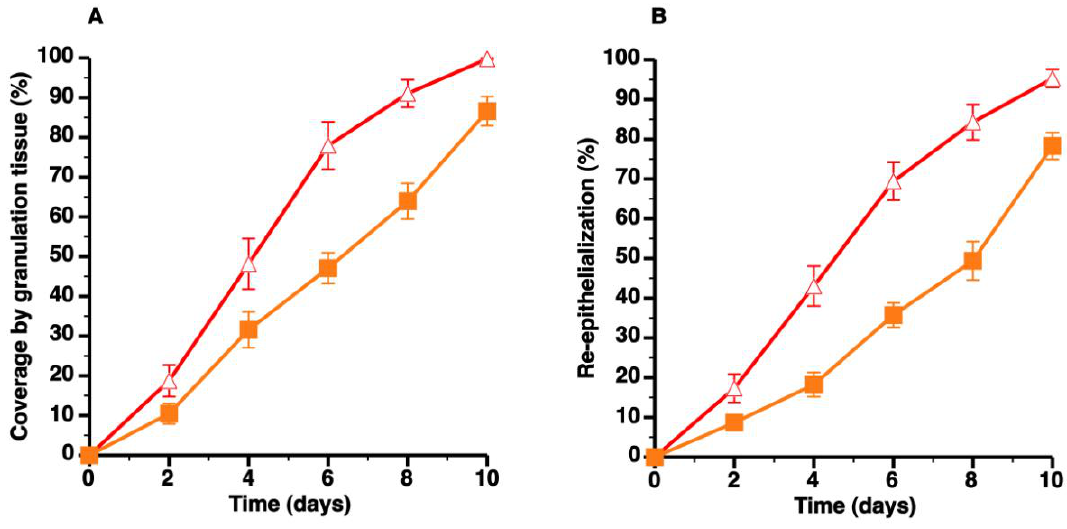
Figure 2. Direct comparison of wound healing in C57BL/6 LDLr −/− CC diet mice (Δ) and C57BL/6 apo E −/− SC diet mice (  ). Panels A and B illustrate the time course of wound coverage by granulation tissue and by newly formed epithelium, respectively, both expressed as percentage of the original wound surface. All data represent means ± SEM.